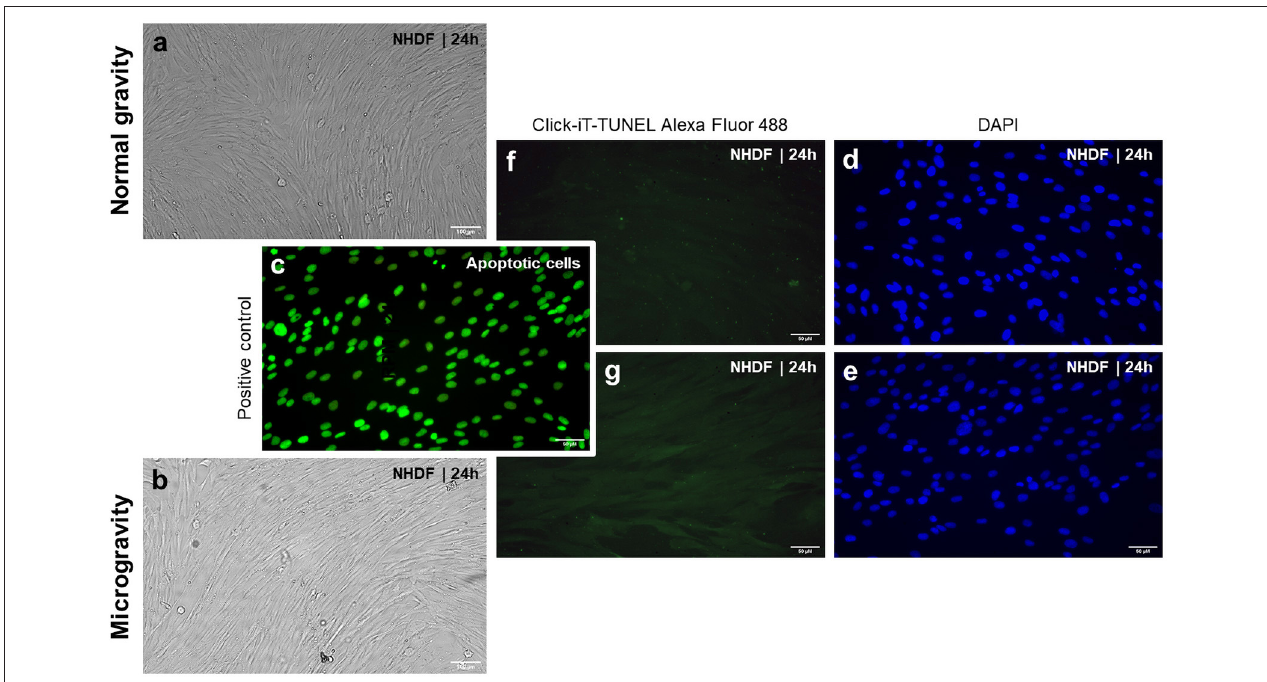
FIGURE 3 | Phase contrast microscopy of normal human dermal fibroblasts (NHDF, catalog number C-12300; PromoCell GmbH, Heidelberg, Germany): (a) NHDF cultured under static 1 g conditions and (b) NHDF exposed to the RPM for 24h. Click-IT terminal deoxynucleotidyl transferase dUTP nick end labeling (TUNEL) assay [(Thermo FisherScientific, Waltham, Massachusetts, USA; Click-iT TUNEL Alexa Fluor 488 (cat# C10245)] performed on NHDF exposed to 1 g (f,d) , and the random positioning machine (RPM) (g,e) . Green staining indicates free fluorophores in the cytoplasm in all images with the exception of the positive control (c) . In the positive control, samples have been pretreated with DNase to induce DNA fragmentation, which is visualized by an enrichment of the fluorophores in the nucleus. Blue staining (DAPI) highlights the cells’ nuclei (d,e) . Green stained nuclei present apoptotic cells as shown in (c) . None of the applied experimental approaches (1 g and RPM) had induced apoptosis in the cells (f,g) . The evaluation was done using a Leica DM 2000 microscope equipped with an objective with a calibrated magnification of x400 and connected to an external light source, Leica EL 6000 (Leica Microsystems GmbH, Wetzlar,